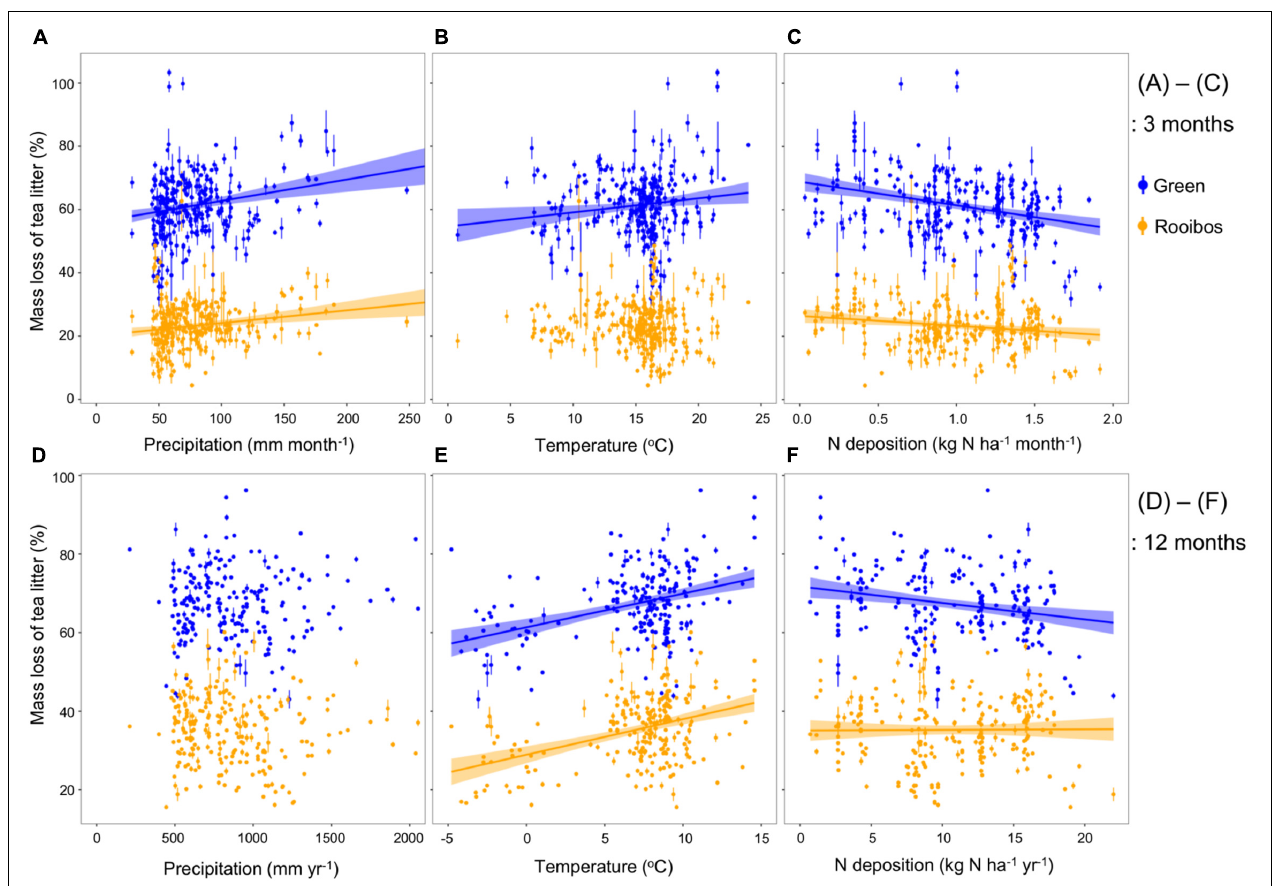
FIGURE 4 | Temperate-biome relationships between mass loss of Green tea and Rooibos tea and precipitation (A,D) , air temperature (B,E) , and N deposition (C,F) after 3-month (A–C) and 12-month (D–F) incubation periods. Blue and orange circles show the means and the bars are the standard errors based on the total number of observations. Band shows 95% confidence interval. Relationships without regression lines show non-significant